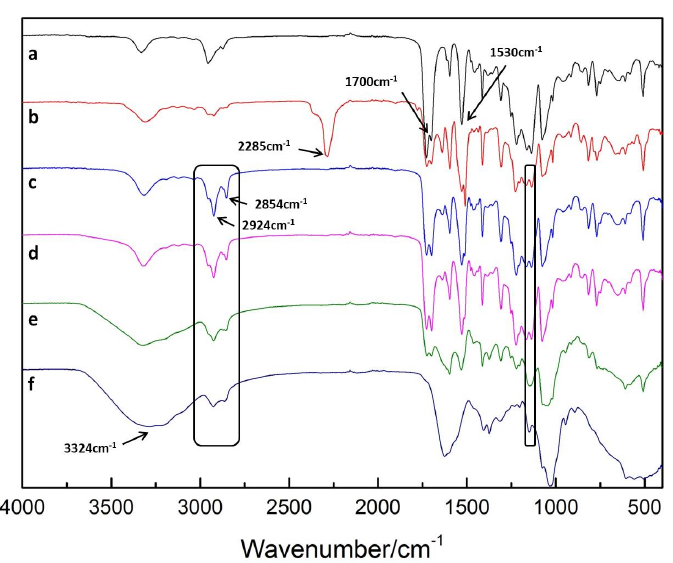
Figure 2. ATR − FTIR spectra of ( a ) PU; ( b )PU-NCO; ( c )PU-PHMG; ( d ) PU-(PHMG/HA) 1 /5-5; ( e ) PU-(PHMG/HA) 5 /5-5; ( f ) PU-(PHMG/HA) 10 /5-5.